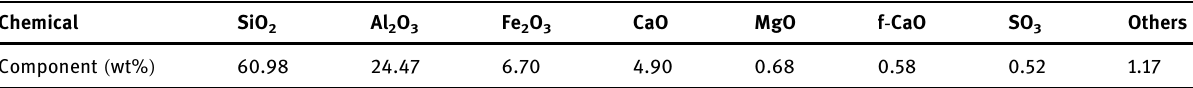
Table 1: Chemical composition of FA Chemical